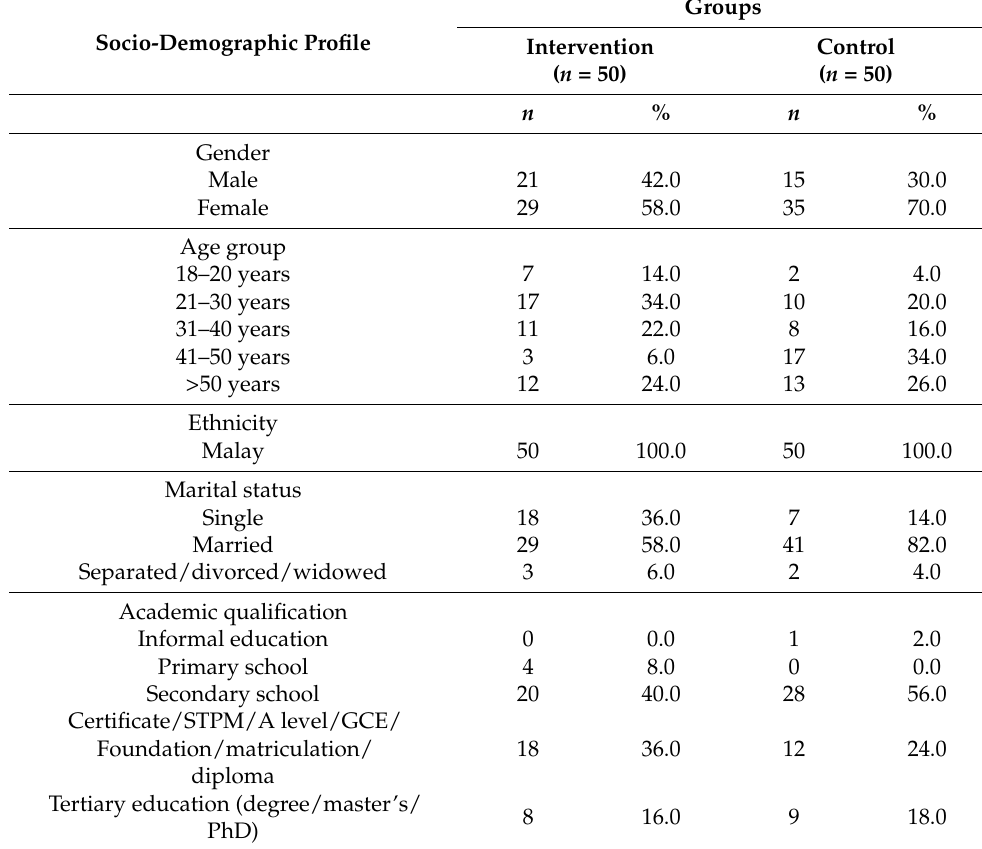
Table 1. Socio-demographic data of the respondents ( n =